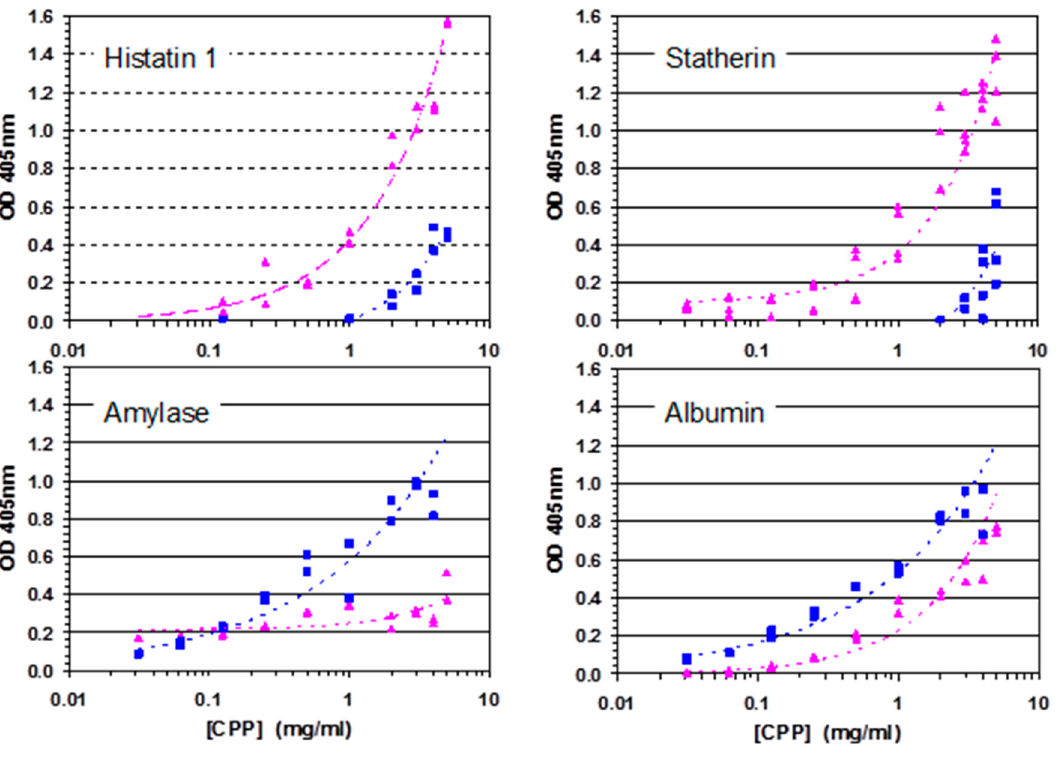
Figure 5. ELISA of α S1 -CN (59–79) (triangles) and β -CN (1–25) (squares) binding to ( A ) Histatin 1; ( B ) Statherin; ( C ) Amylase; ( D ) Albumin.